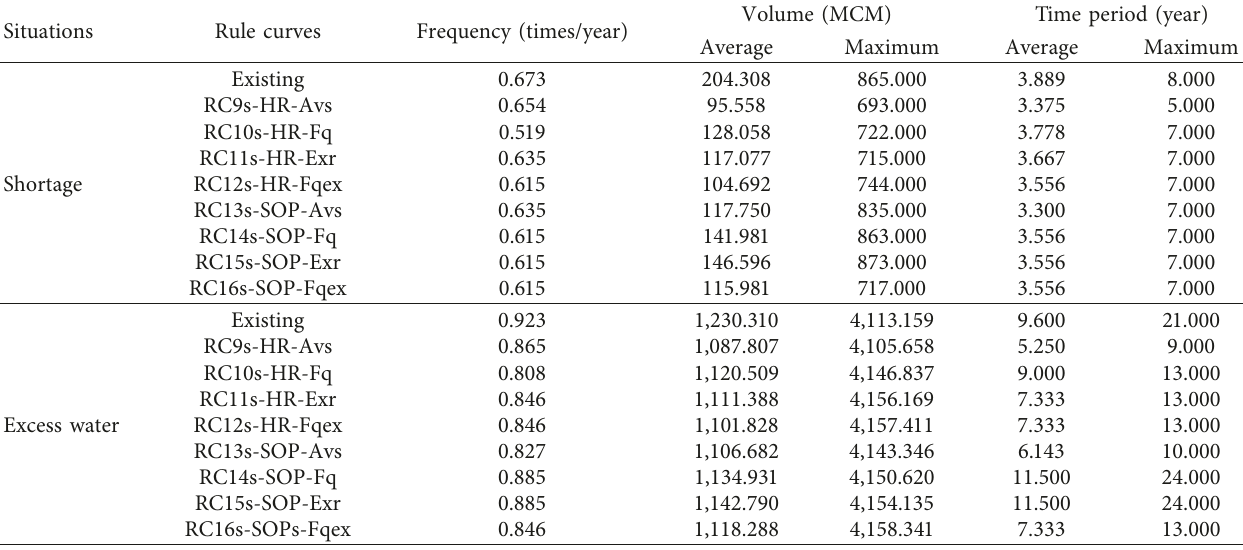
Table 4: The situations of water shortage and excess water considering historic inflow 52 years from MPA considering sedimentation and using HR criteria.